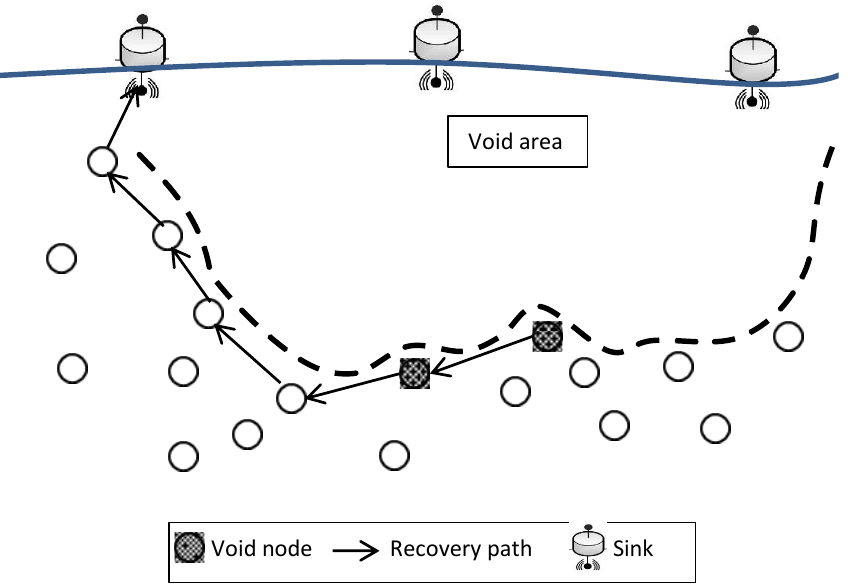
Figure 5. HydroCast void handling technique.